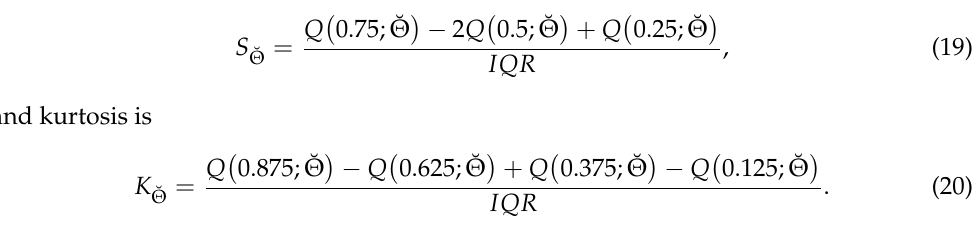
Fig. 5. Plots of skewness of HLUG-TI for certain parameter values.